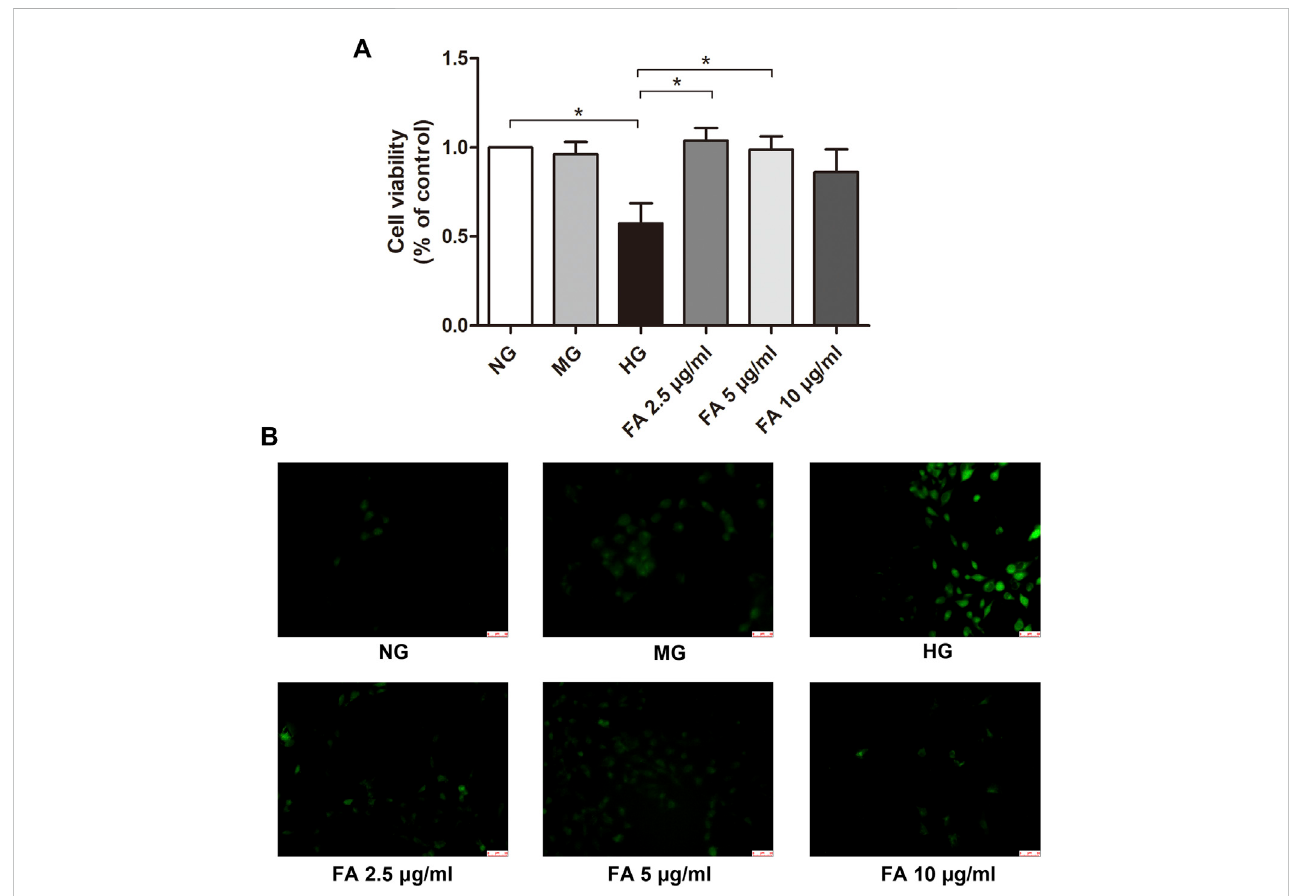
FIGURE 8 Assessment of podocyte viability by Cell Counting Kit-8 assay and reactive oxidative species measurement by fl uorescence. (A) Podocyte viability was examined by Cell Counting Kit-8 assay after various treatments for 48 h. (B) Reactive oxidative species which were labeled with green fl uorescence were detected after podocytes were exposed to normal glucose (NG), isosmotic mannitol (MG), or high glucose (HG) for 48 h with or without Forsythiaside (FA 2.5 μ g/mL, FA 5 μ g/mL, and FA 10 μ g/mL) treatment. Magni fi cation: ×200. Scale bar = 50 µm. Data are mean ± S.E.M. * p < .05. FA: